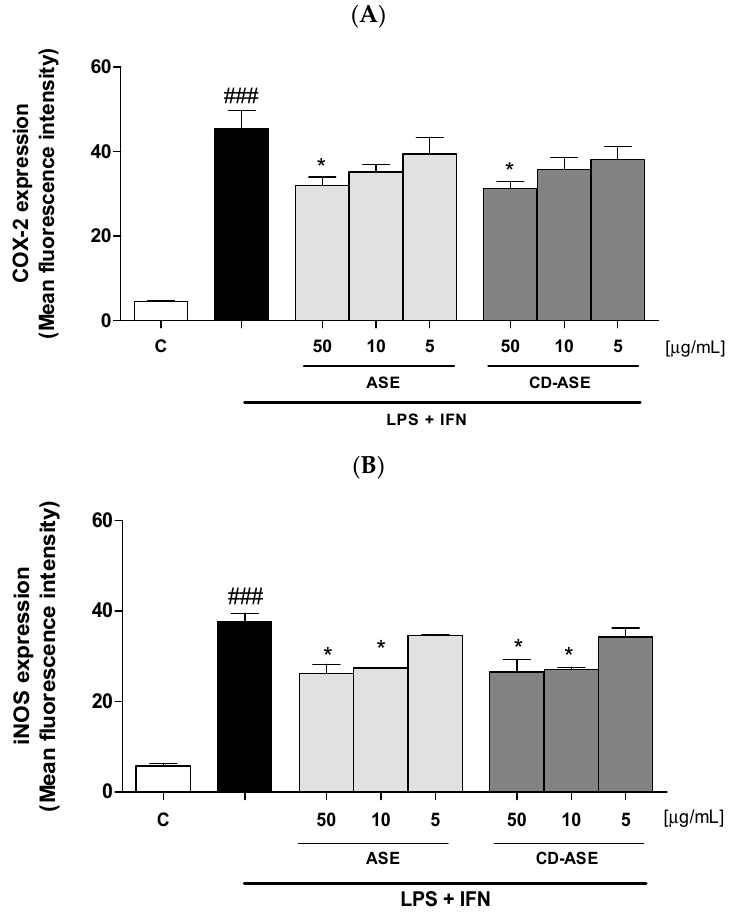
Figure 8. E ff ect of Acetonic almond skins extract (ASE), and formulation (CD-ASE; 50–5 µ g / mL) on COX-2 ( A ) and iNOS ( B ) expression, induced by LPS + IFN in IEC-6 cells, evaluated by the cytofluorimetric technique. * denotes p < 0.05 vs. LPS + IFN; ### denotes p < 0.001 vs. control (C).